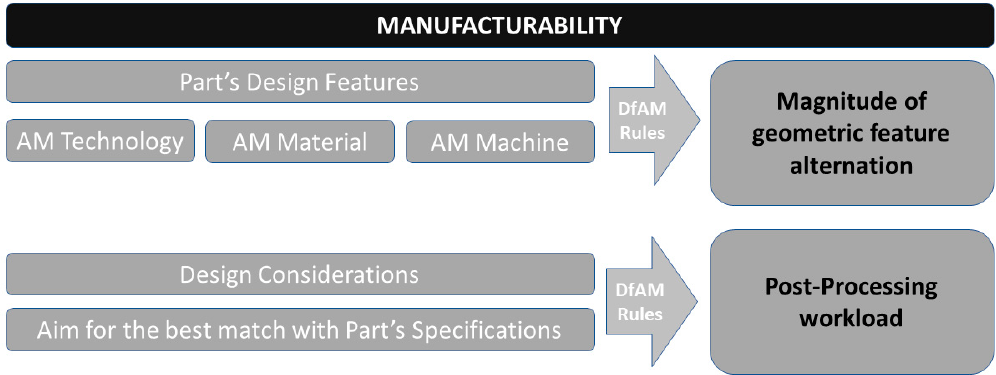
Figure 2. Part manufacturability for AM.